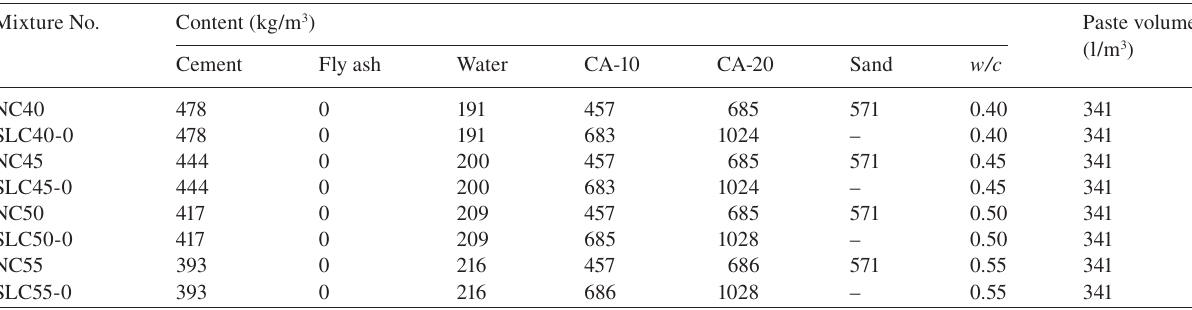
Table 1 Mixture proportions for “ sandless ”